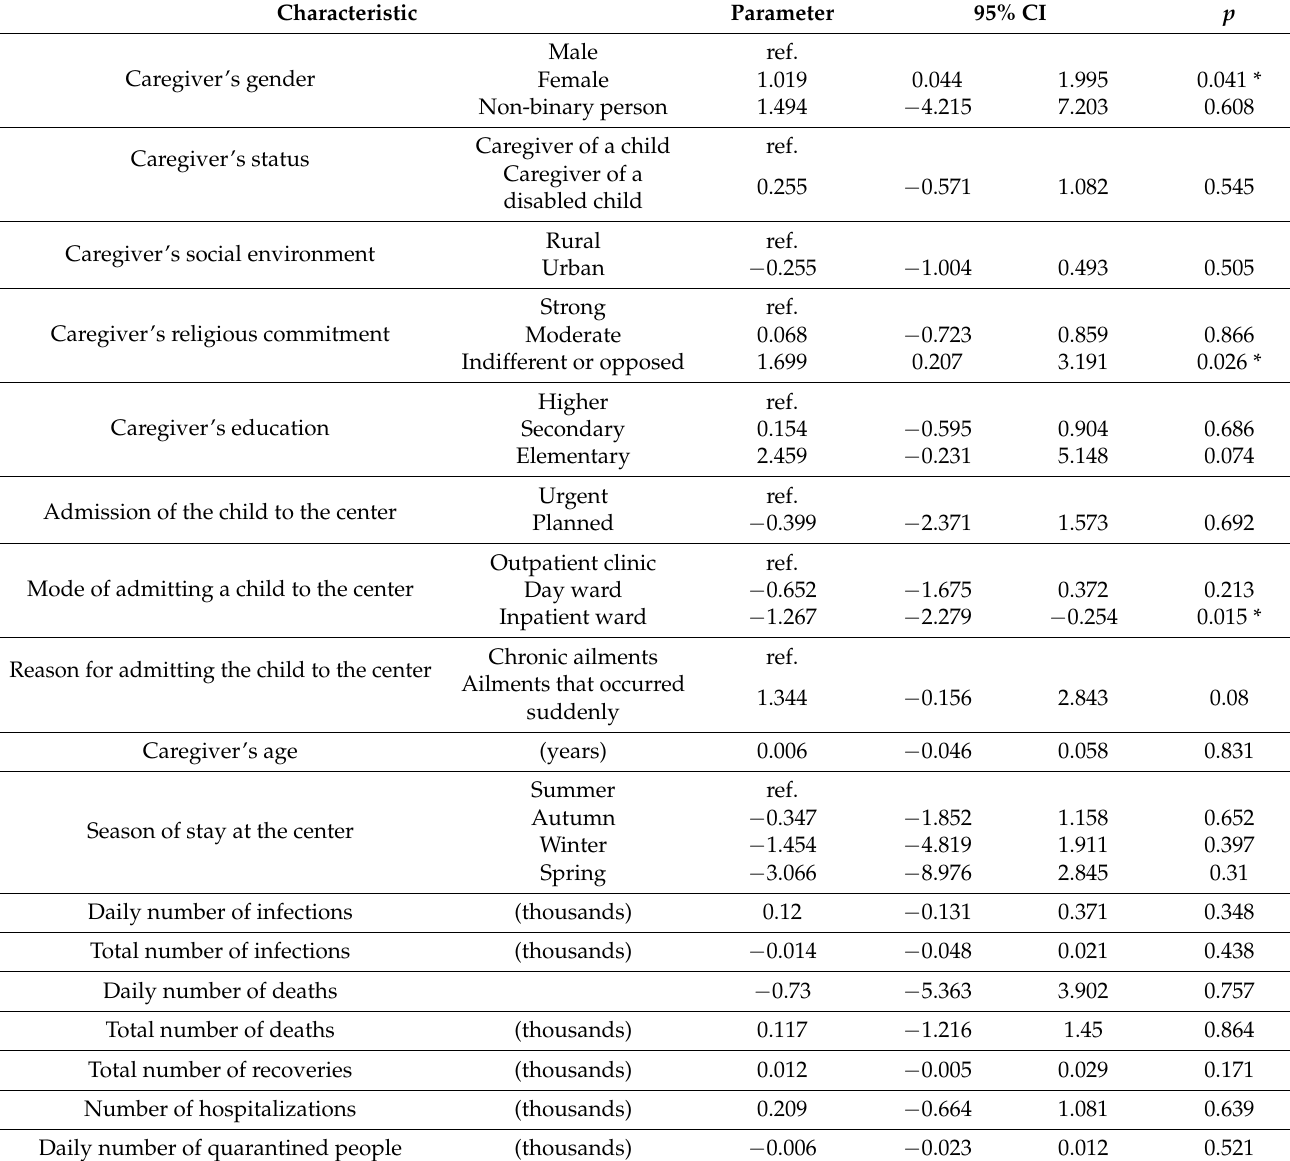
Table 10. Predictors differentiating the level of anxiety: multivariate analysis.